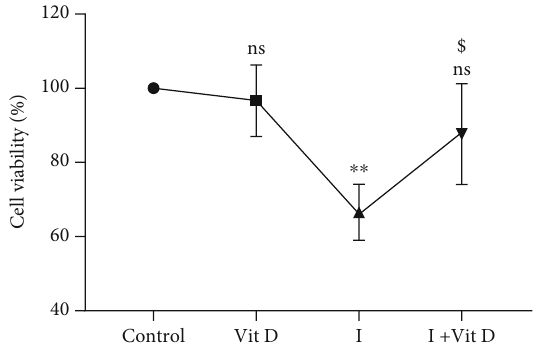
Figure 6: MTT 3-(4,5-dimethyl (thiazol-2-yl)-2,5-diphenyl tetrazolium bromide) assay to quantify cell viability in Vero cells exposed to iohexol and vitamin D3. Results are represented as mean ± SD . One-way ANOVA and Tukey posttest ( n = 4 ) were used to analyse the results. ns: not signi fi cant; ∗ p < 0 : 05 , ∗∗ p < 0 : 01 , and ∗∗∗ p < 0 : 001 (2-tailed) in comparison with the control; $ p < 0 : 05 , $$ p < 0 : 01 , and $$$ p < 0 : 001 (2-tailed) iohexol (I) versus iohexol+vitamin D (I+Vit D)